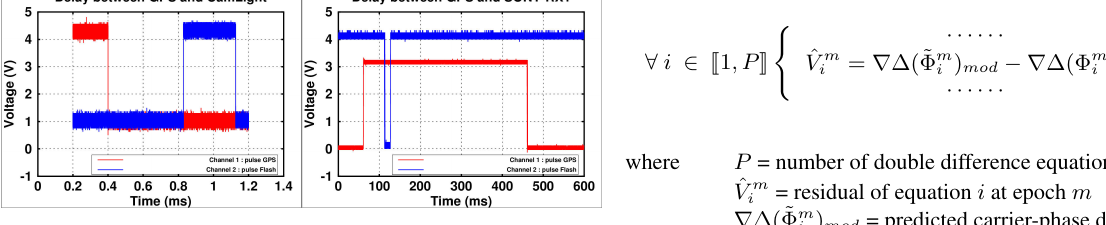
Figure 8: Measurement of electronic delay © O. Martin